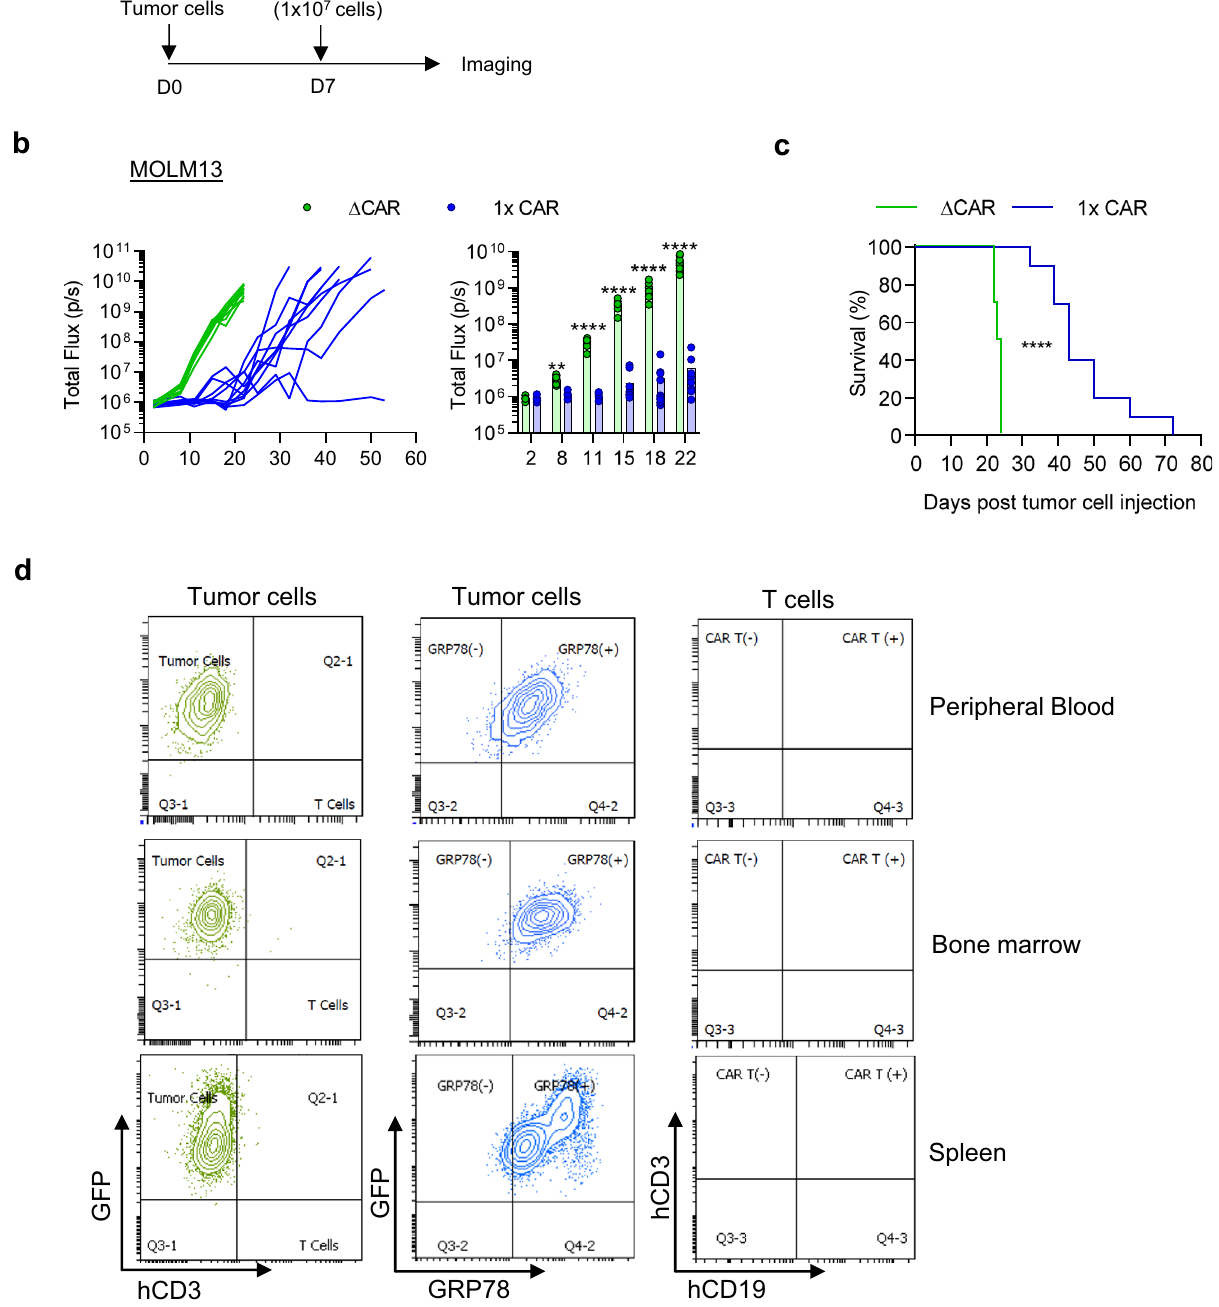
Fig. 6 GRP78-CAR T cells have potent anti-AML activity in vivo. a Schematic of the in vivo experimental design. b NSG mice were injected with MOLM13 (5 × 10 3 ) cells i.v. (tail vein), and on day 7 received a single i.v. dose of 1 × 107 T cells. IVIS imaging was performed twice weekly ( N = 10, ** p = 0.001, **** p < 0.0001, two-way ANOVA with multiple comparisons). The data in ( b ) are presented as mean values ± SD. c Survival curve ( N = 10, p < 0.0001, Log-rank test). d Peripheral blood, spleen, and bone marrow was collected from mice on days 39 – 45 post tumor injection. Single cell suspensions were stained for GRP78, hCD3, and hCD19 and analyzed by fl ow cytometry to determine the presence of cell surface GRP78 + MOLM13 cells as well as CAR T cells; representative dot plots are shown. Source data are provided as a Source data fi